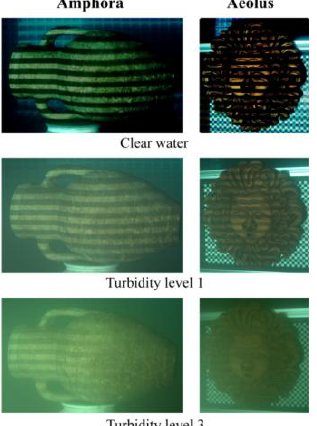
Figure 6. Images of the two objects with a projected grey-code pattern, acquired at different turbidity